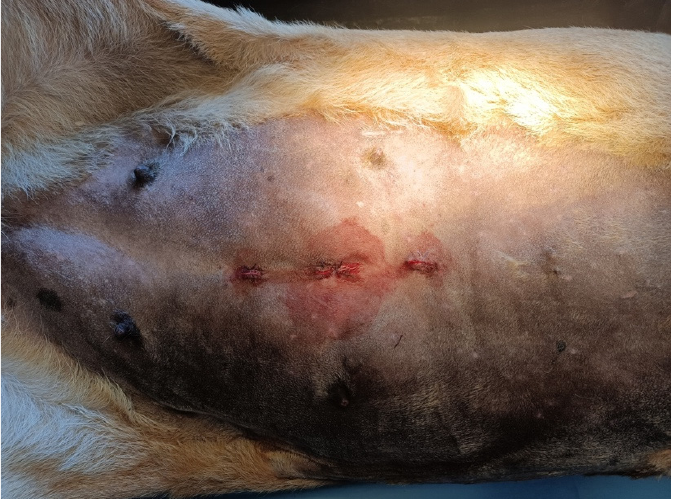
Figure 5. Portals sutured. Cranial is on the right.